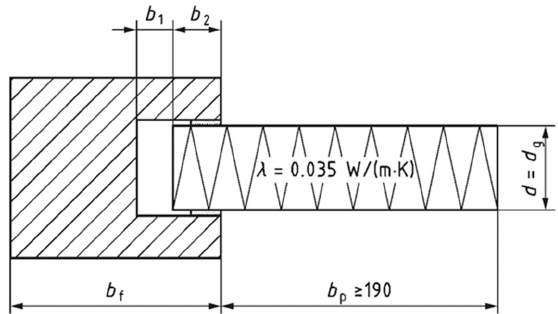
Figure 18. The view of frame and installed panel section in EN 10077-2